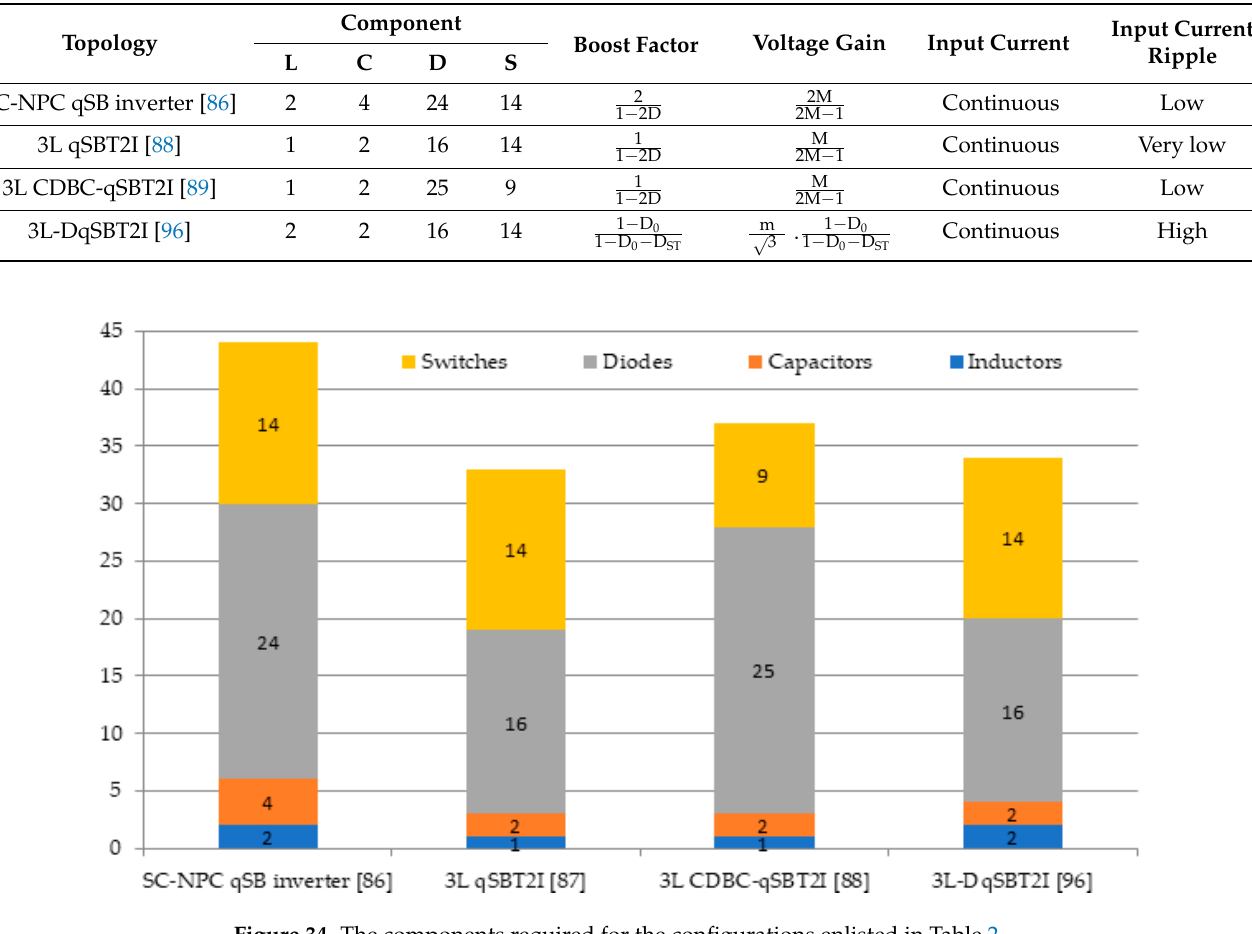
Figure 34. The components required for the configurations enlisted in Table 2.